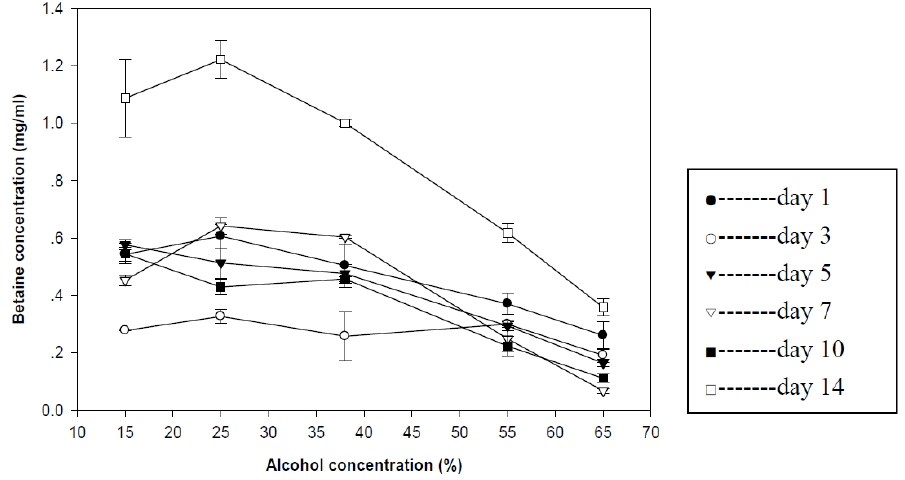
Figure 1. Betaine concentration in goji wine. Results were expressed as mean ± standard deviation ( n =